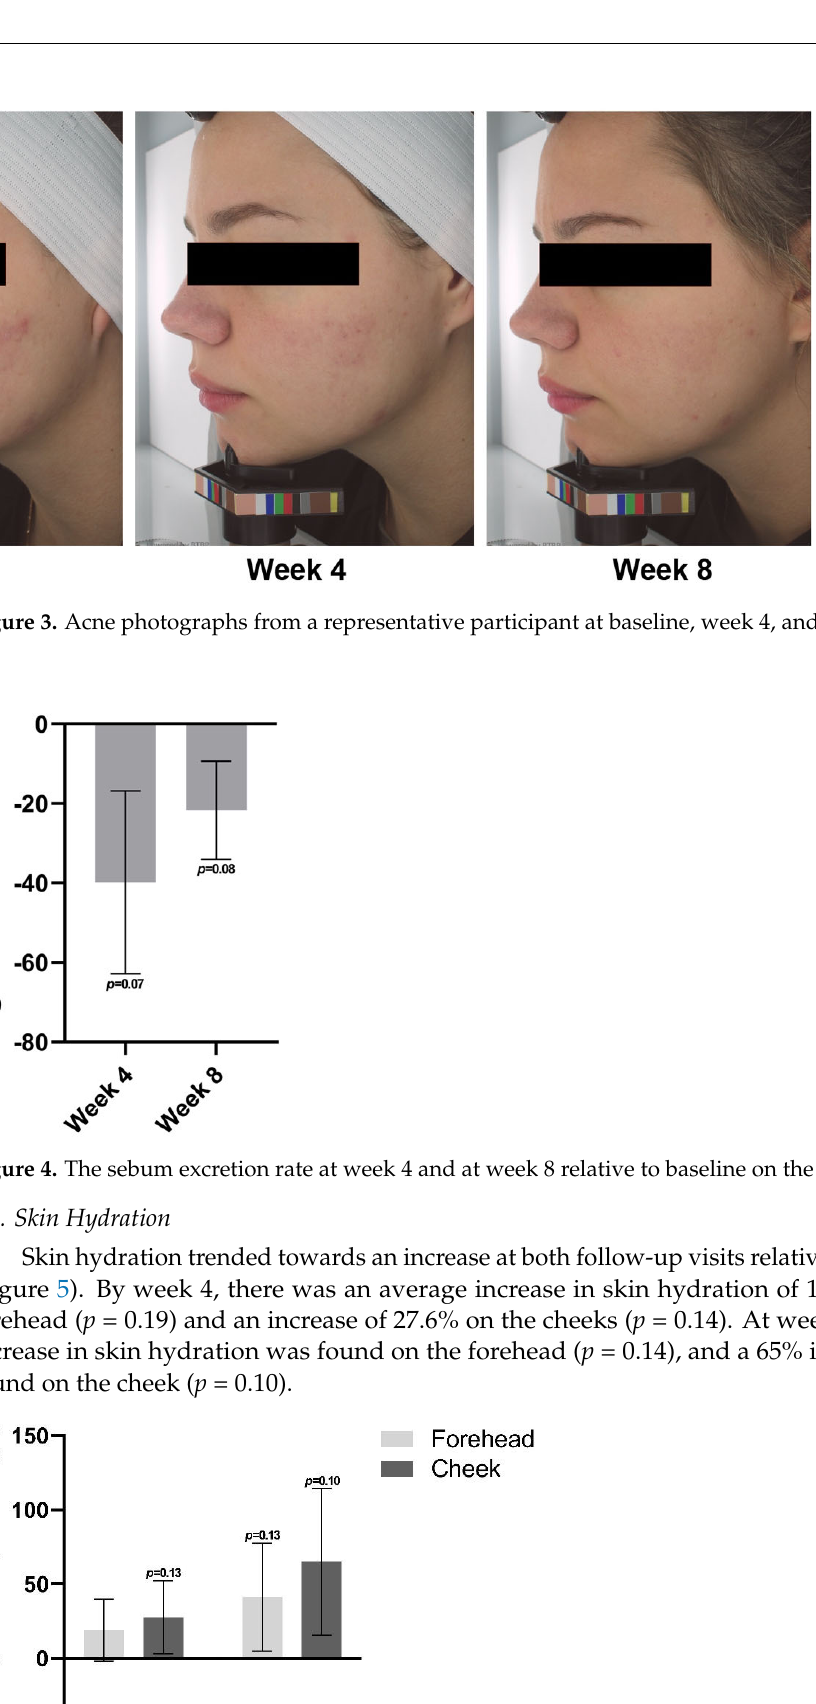
Figure 5. Skin hydration at week 4 and week 8 relative to baseline. 3.4. Mood and Affect Score After 8 weeks of use, the acne regimen was found to improve components of positive and negative effects (Figure 6). Overall, participants had an average 0.73 point increase in feeling “strong” ( p ≤ 0.05) and a 0.53 increase in feeling “inspired” ( p < 0.05). Additionally,